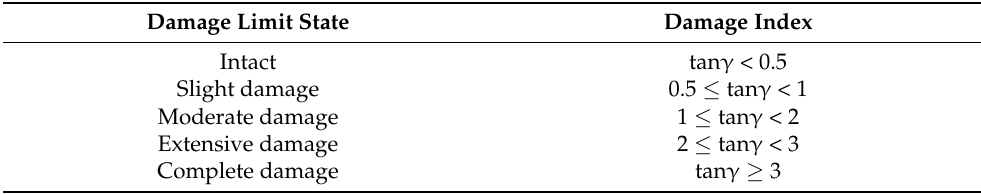
Table 5. Definition of different damage states for the water stop.